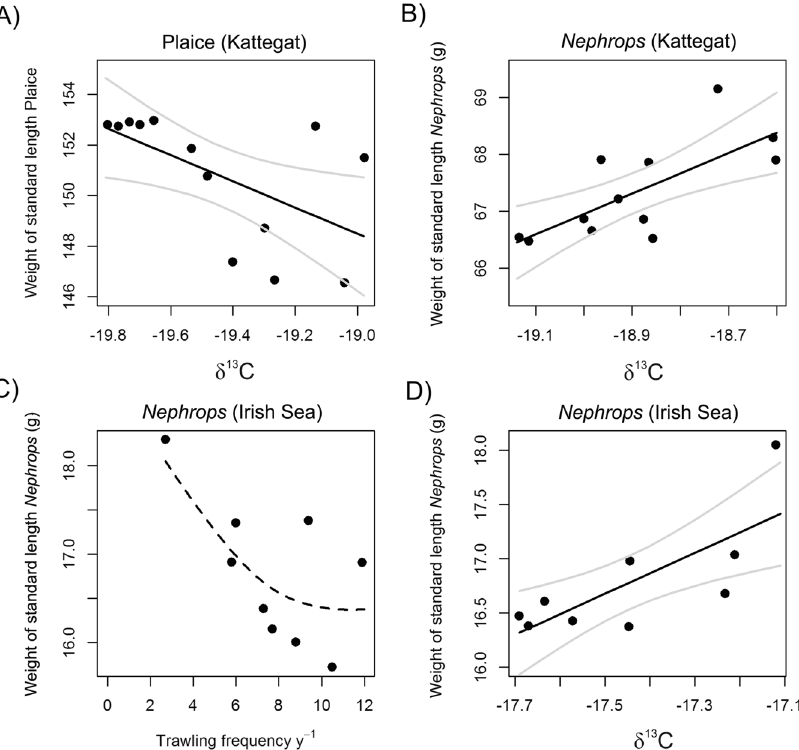
Figure 4. Relationship between δ 13 C and condition as weight of a standard length fish ( A ) plaice and ( B ) Nephrops in the Kattegat. ( C ) Weight of standardized length Nephrops (g) with increasing trawling frequency in the Irish Sea. Standardized length for Nephrops refers to carapace length in all instances. Only significant relationships are presented except for ( D ), the relationship between δ 13 C and condition expressed as weight of a standard length Nephrops from the Irish Sea. The dashed line represents the non-significant prediction of the GAMM model. Nephrops weight displayed in the Irish Sea are predictions for clawless male individuals, see Methods. The significant relationship of δ 15 N and Nephrops condition in the Kattegat (Table 3) was not displayed due to lower r 2 and significance values compared to δ 13 C.